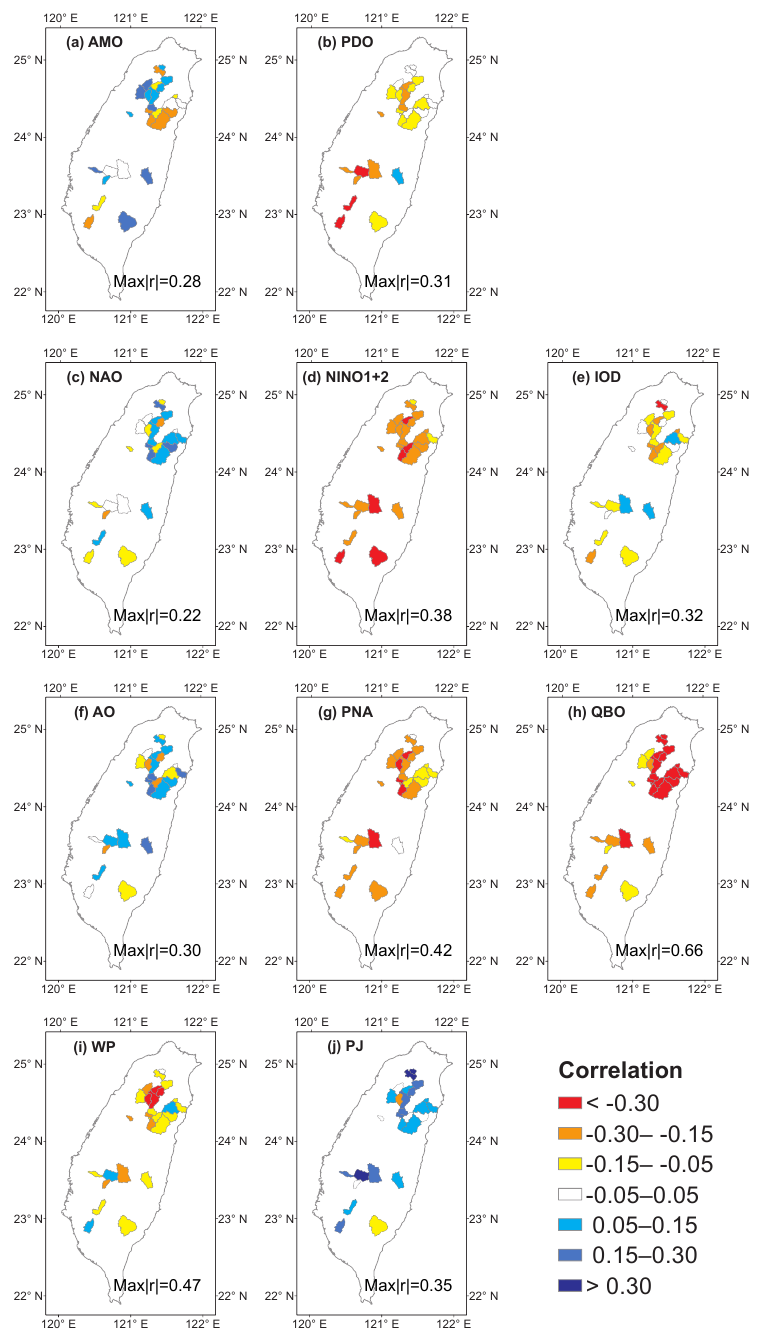
Figure 3. As in Fig. 2 but for lagged correlations (JAS runoff vs. ONDJFMAMA teleconnection